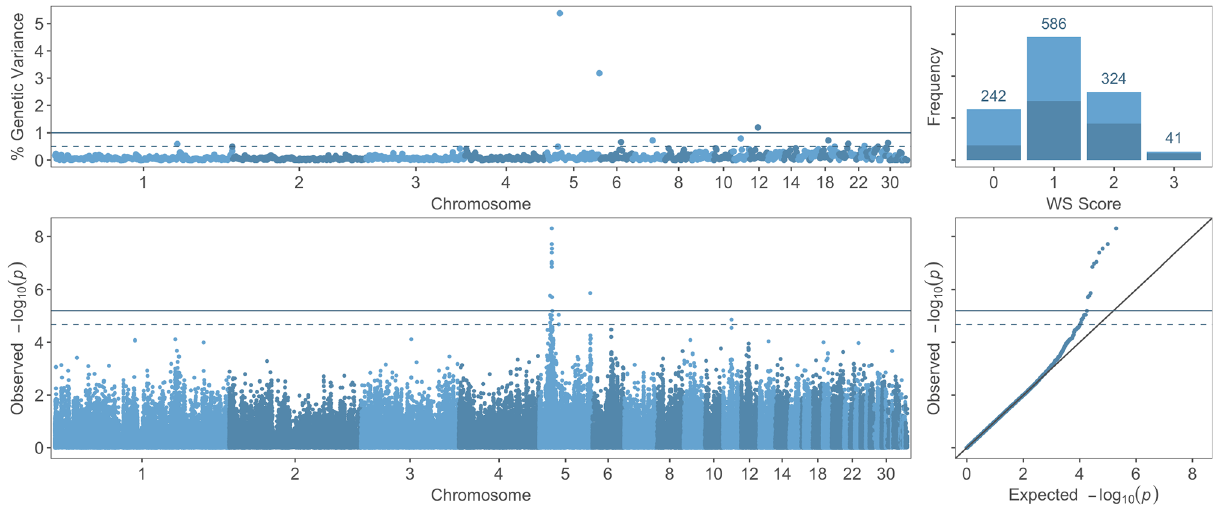
Figure 2. Genome-wide association results for white striping (WS) score using multi-marker (BayesB) and single-SNP (mixed linear model) analyses. (Top Left) Percentage of genetic variance explained by 1-Mb regions across the genome for WS score. (Top Right) Distribution of WS scores across progeny used in genome-wide association analyses; dark blue = male, light blue = female. (Bottom Left) Manhattan plot of single-SNP results showing the − log10( p -value) of SNPs ordered by chromosome and position. (Bottom Right) Quantile–quantile plot of p-values from single-SNP results of WS score. Solid and dashed lines indicate significant and suggestive thresholds, respectively, for each